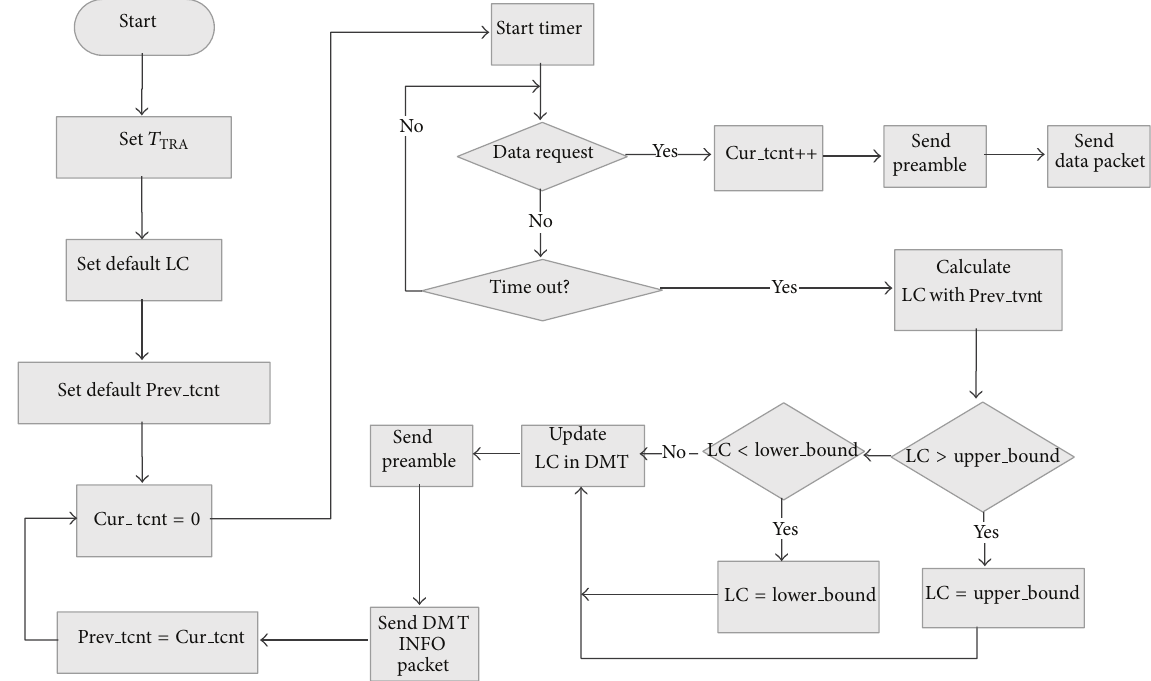
Figure 1: Transmission rate